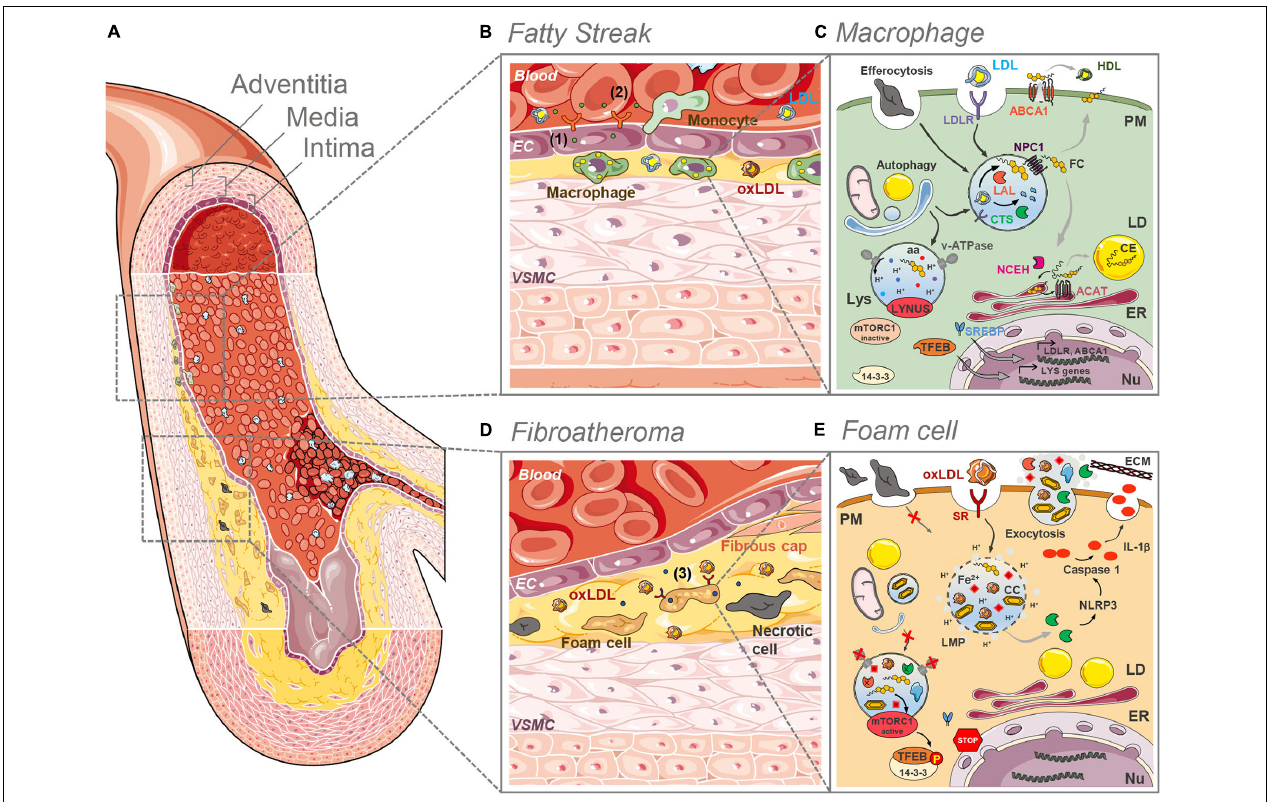
FIGURE 1 | Lysosome (dys)funtion in the initial and final stages of plaque development. (A) Anatomically, large arteries consist of three well defined and morphologically distinct layers. The intima, the innermost layer in direct contact with the blood stream, comprising an endothelial layer surrounded by a connective tissue basement membrane with elastic fibers. The media is the thickest layer and consists primarily of VSMCs. The outermost adventitia, with connective tissue and varying amounts of collagenous and elastic fibers, attaches the artery to the surrounding tissue. (B) In the initial stages of plaque development (fatty streak) LDL infiltrates the intima, where it undergoes oxidation and other modifications. The formed oxLDL causes the proliferation of VSMCs and triggers the secretion of adhesion molecules (1) and chemoattractants (2) by ECs, which in turn recruit monocytes from the blood stream. In the intima, monocytes differentiate into macrophages that clear LDL and oxLDL. (C) In macrophages of the intima the LDL is taken up by the LDLR and routed to the lysosomes (Lys) where the acid lipase LAL hydrolases the CE and TG to FC and fatty acids. The cathepsin (CTS) proteases breakdown the protein apoB. FC is exported from the lysosomes by NPC1 and then directed to the different organelles (ER, PM, etc.). The ER enzyme ACAT esterifies cholesterol to CE, which are stored in cytosolic LDs. CE can be converted back to FC by NCEH. Excess FC is effluxed via the ABCA1 plasma membrane (PM) transporter. Efferocytosis and selective autophagy converge to the lysosomal compartment for degradation of substrates sequestered in phagosomes and autophagosomes, respectively. Intralysosomal hydrolysis dependents on the activity of the proton (H + ) pump v-ATPase that maintains the intraluminal acidic pH. Nutrients such as aminoacids (aa) and FC are sensed by the LYNUS machinery of which mTORC1 is a part of. Abundance of nutrients dictates the inactivity of mTORC1 and the translocation of (14-3-3) free TFEB to the nucleus (Nu) to drive the transcription of lysosome and autophagy genes. The uptake of LDL is regulated by the action of the SREBP transcription factors. (D) In advanced